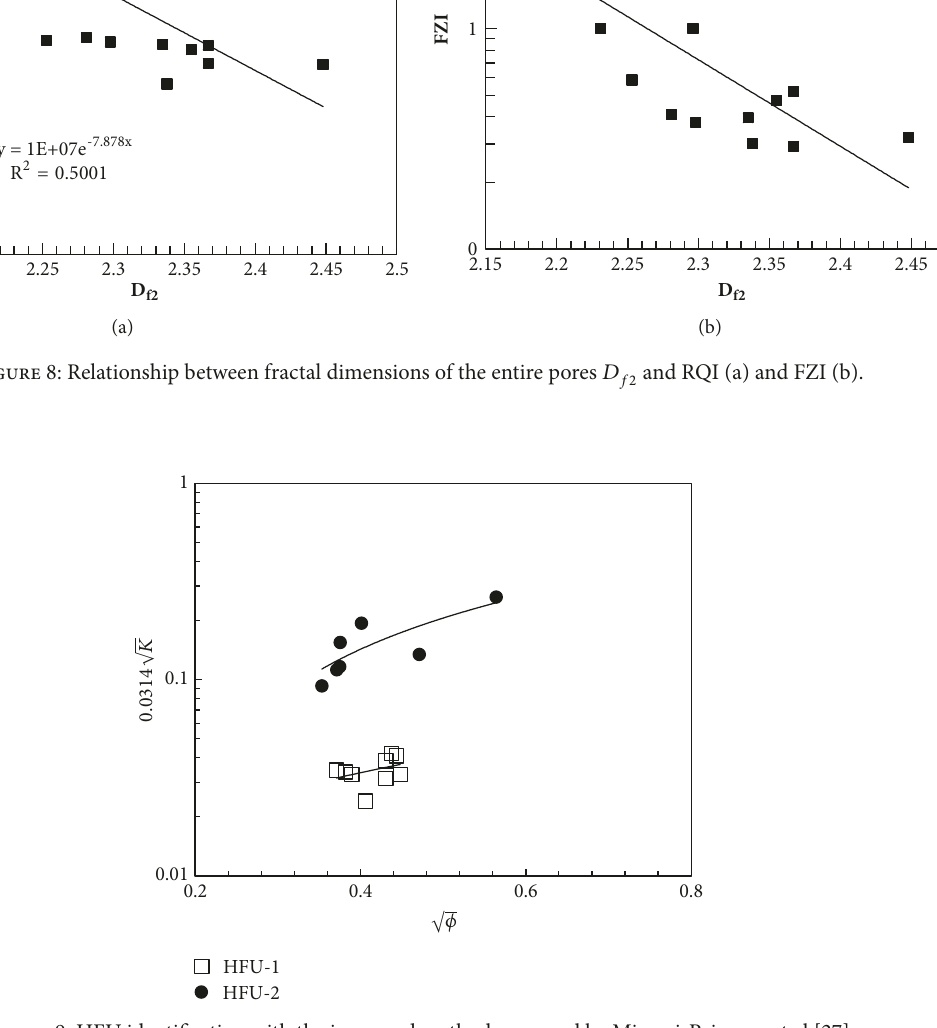
Figure 9: HFU identification with the improved method proposed by Mirzaei-Paiaman et